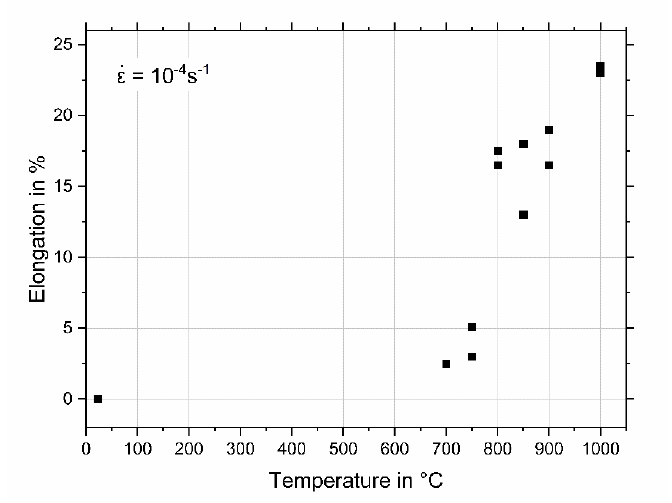
Figure 4. Elongation at fracture (full square symbols) obtained from tensile tests conducted on the same alloy as in this study, data from [12].